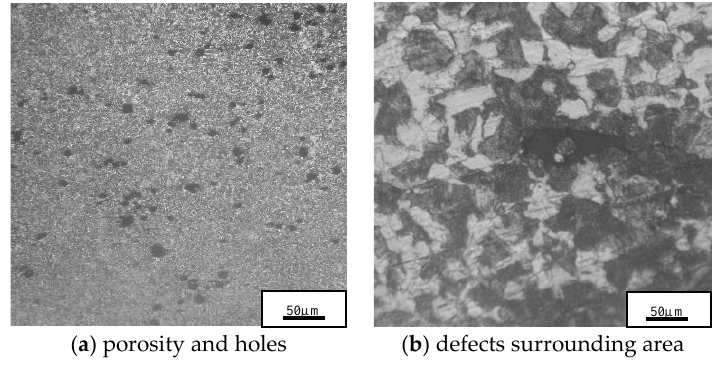
Figure 7. Magnified morphology of microstructure in cracks and holes area.